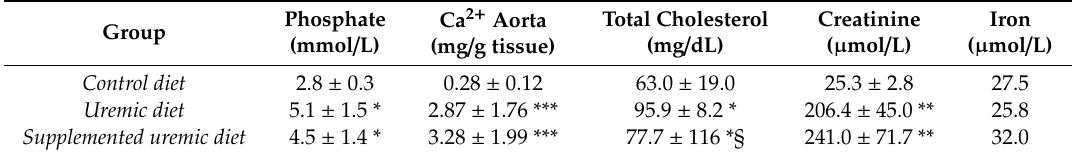
Table 2. Biochemical parameters measured after six weeks of diet treatment. * p < 0.05 vs. control